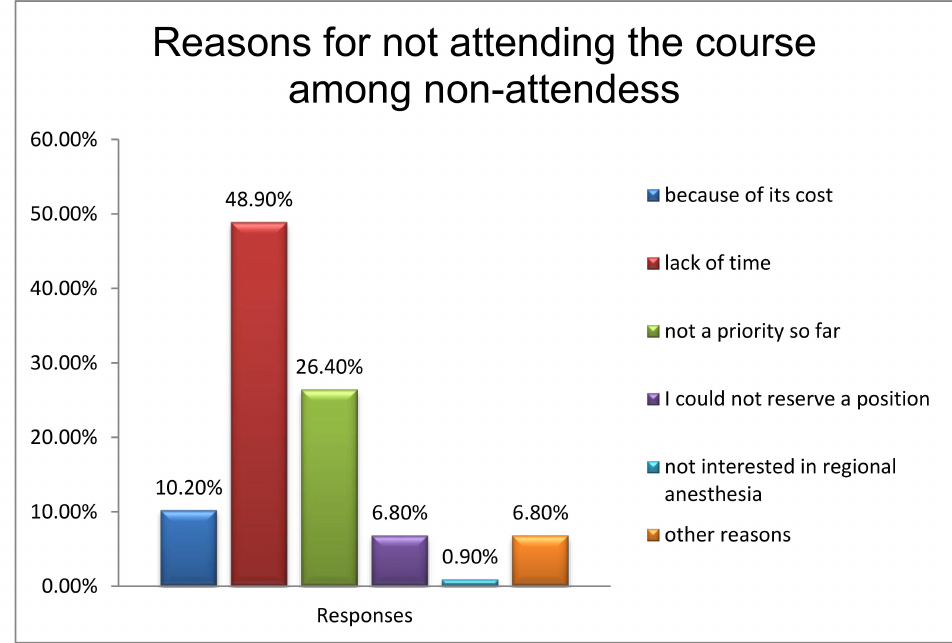
Figure 2. Reasons for not attending the regional anesthesia course among anesthesiologists who had not attended the